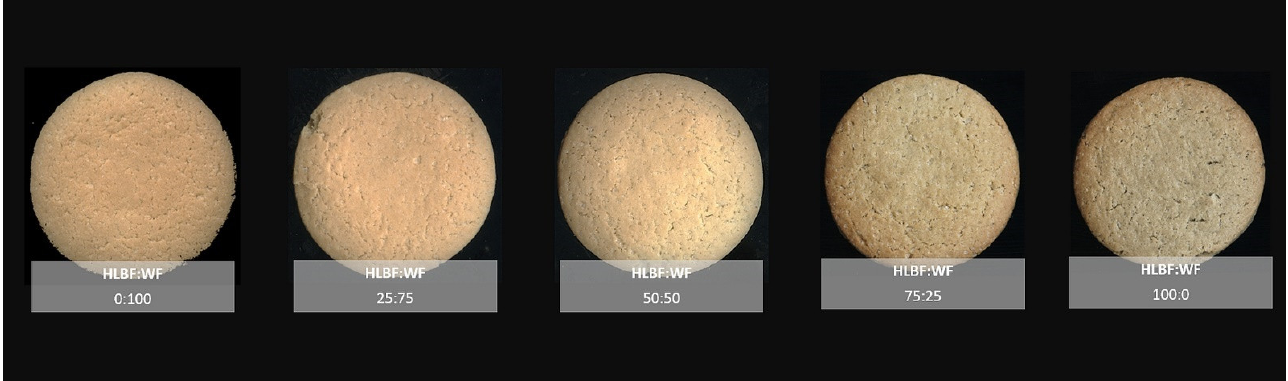
Figure 1. The composite cookies containing wheat flour (WF) and hulless barley flour